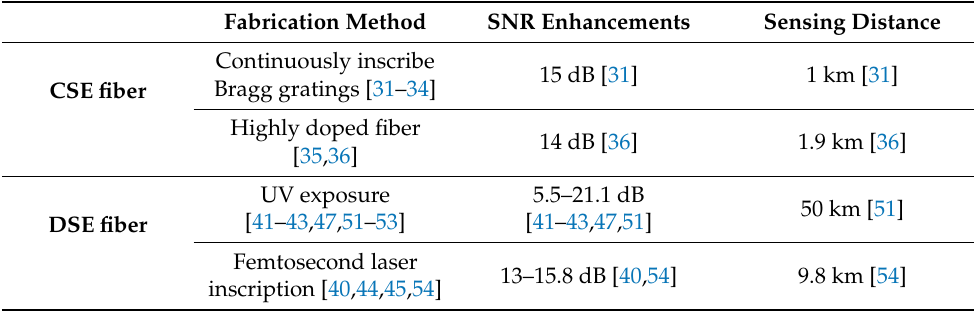
Table 2. Performance summary for CSE and DSE fibers.